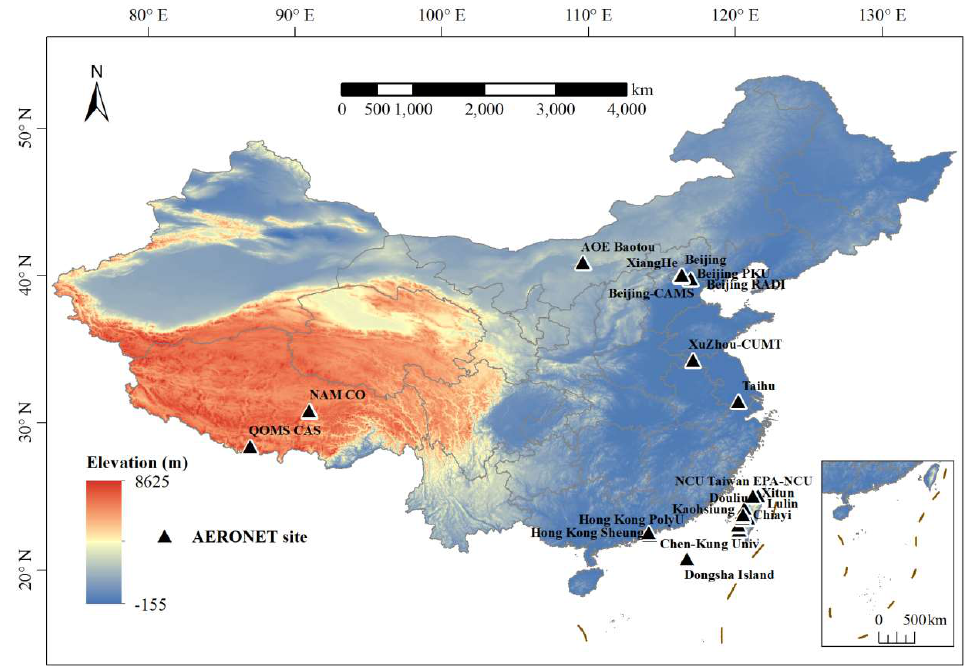
Figure 1. Spatial distribution of 23 AERONET sites in China for evaluating satellite-based AOD